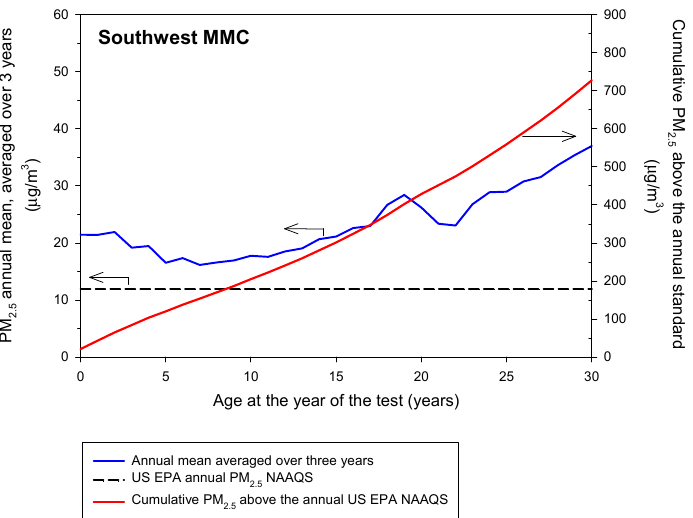
Figure 1. Backward annual trends of the PM 2.5 annual mean concentrations averaged over three years and the respective cumulative PM 2.5 concentrations determined for the southwest sector of MMC according to the age of the volunteers starting in 2019. The average annual PM 2.5 exposure was calculated as 28.36 µg/m 3 /year.